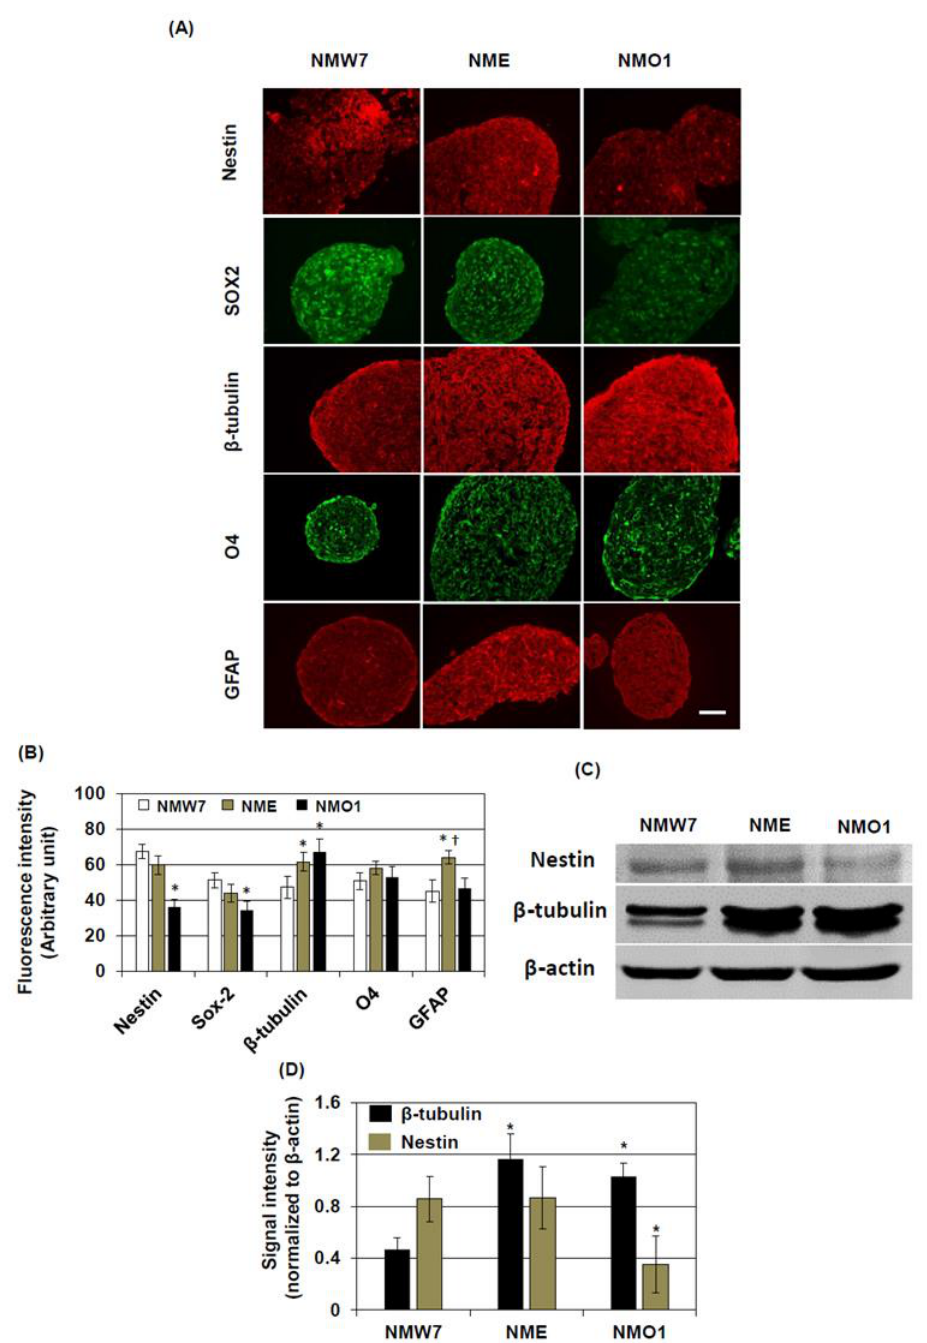
Figure 3. Characterization of neuronal stem cell lines: To characterize NMW7, NME, and NMO1 cells, the protein expression levels of the cell type markers including SOX2, nestin, β -tubulin, O4, and glial fibrillary acidic protein (GFAP) were evaluated under neurosphere culture conditions. ( A ) Representative photomicrographs ( × 400 magnification) of neurospheres immunostained for the indicated cell type markers are shown here. ( B ) Fluorescence intensities of the cell type markers were quantified as described in the Materials and Methods section, and average fluorescence intensities are shown. ( C , D ) The protein expression of β -tubulin and nestin was further evaluated by Western blotting. Representative of Western blotting data are shown in ( C ). β -actin served as the loading control. ( D ) The protein levels were quantified by densitometry, and average densitometric data normalized to β -actin are presented ( n = 3). Numerical data are presented as average ± SD of at least 3 independent experiments. Statistical significance is denoted as follows: * p < 0.05 vs. NMW7; † p < 0.05 vs. NMW7. Scale bar, 50 μm.